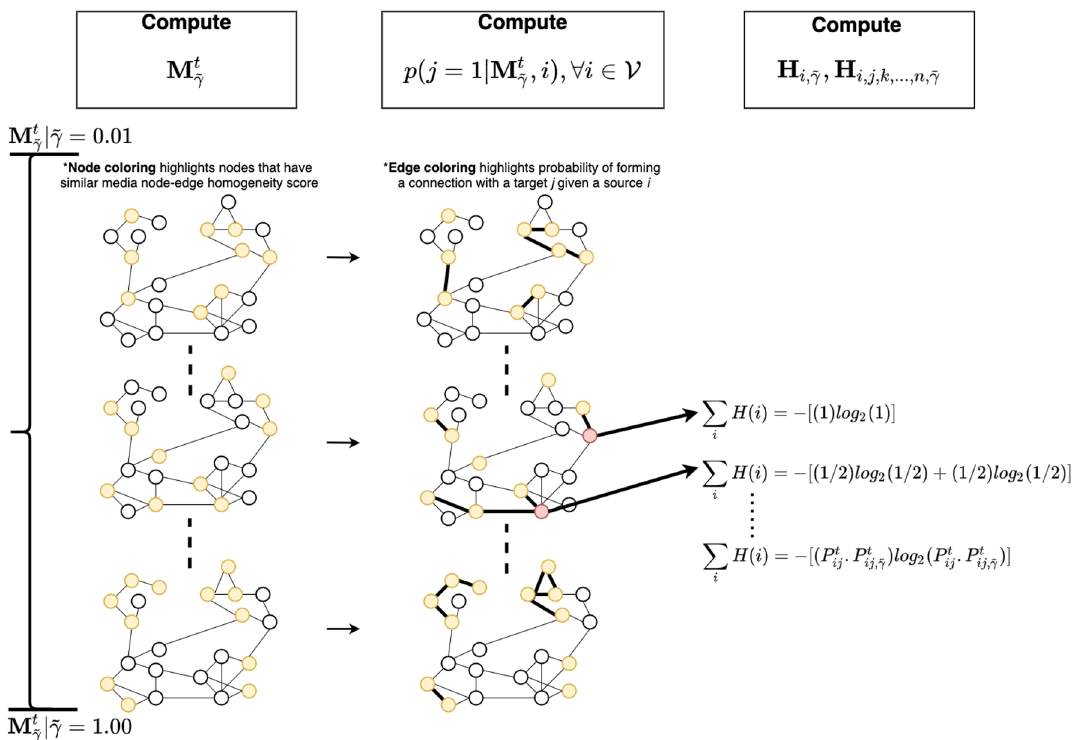
Figure 4. Social media network at time t . The figure presents a visual overview of the steps involved in t ˜ γ varies between 0.01 and 1.00, then computing the probability of computing the MNEH matrix ( M ˜ γ ) when forming a connection with user j given user i , and the entropy contribution of target nodes (colored